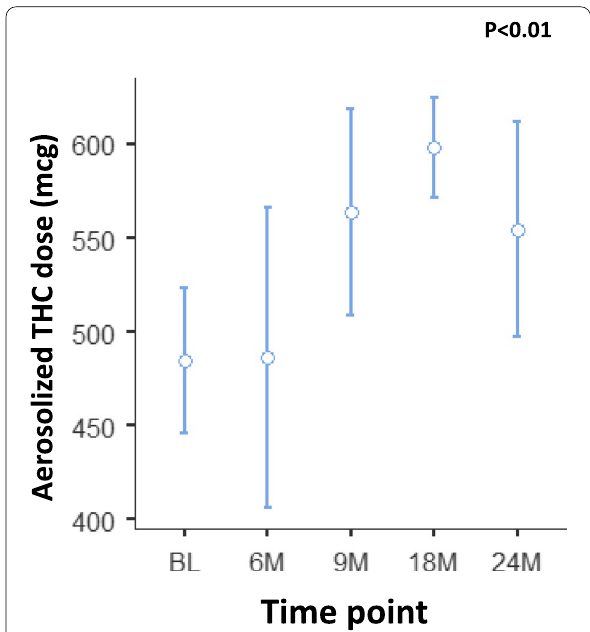
Fig. 5 Aerosolized THC doses after storage of MC in Syqe cartridges at room temperature over 2 years. The middle circle represents the mean value and the upper and lower lines represent the upper and lower 95% confidence interval values. BL, baseline; M, month; THC, (-)-∆ 9 -trans- tetrahydrocannabinol. Statistically significant differences between times of storage were calculated by one-way ANOVA, utilizing Fisher’s exact test analyses (whenever significant, stated as the p value and when not significant stated as N.S.), followed by a Tukey post hoc multiple comparison test (*, p <0.05; **, p <0.01; ***, p